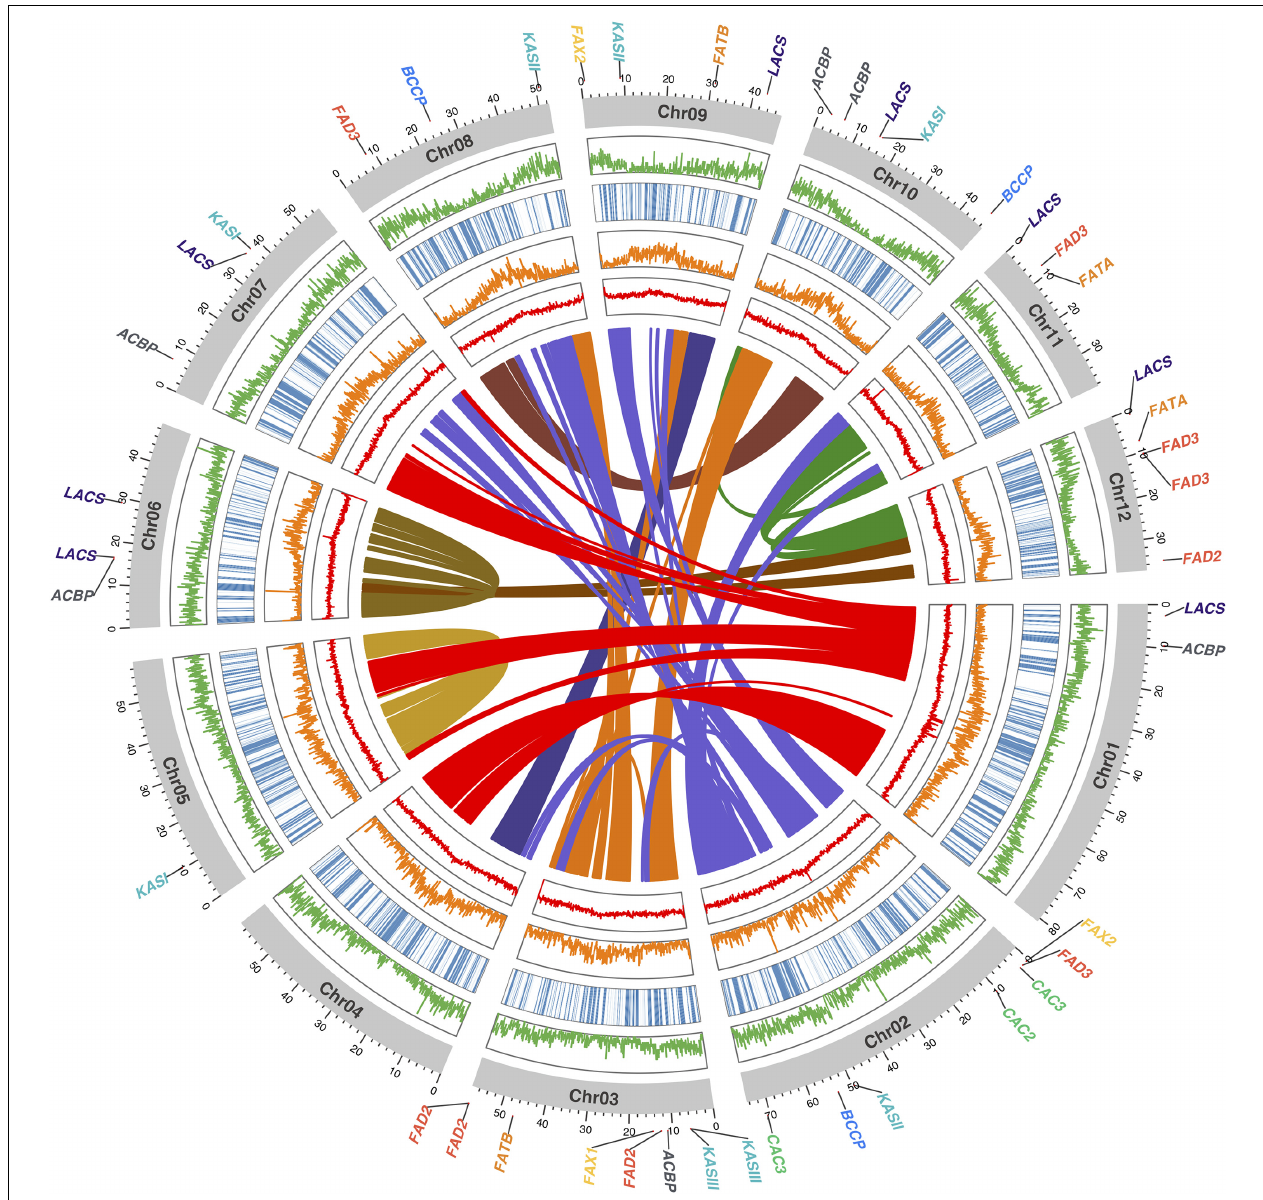
FIGURE 2 | Circos plot of the shea genome, with links between syntenic regions indicated (center). Moving from the center outward, the four circumferential plots per chromosome report mean %GC content (red), number of transposable elements (orange), haplotig coverage (blue heatmap), and number of coding gene models (orange), per 100 kb bin. The coordinate axes track the physical lengths of the chromosomes (Mbp), to which the locations of the 45 fatty acid (FA) biosynthesis homologs identified in this study are